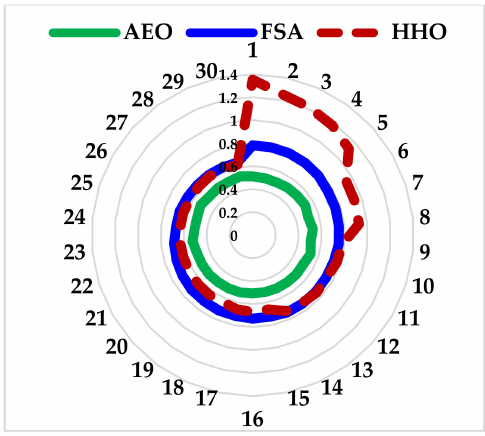
Figure 13. AEO, FSA, and HHO Cost of Energy with DSM at 80% REF and 0% LPSP.